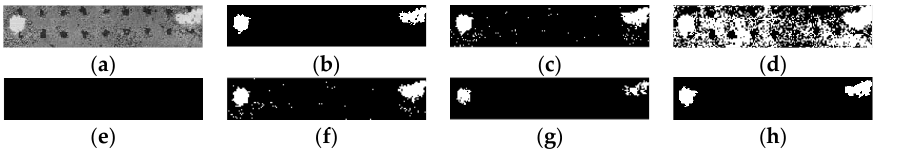
Figure 9. Image13 and its segmentation results: ( a ) #image13, ( b ) ground-truth, ( c ) Otus, ( d ) MRCUT, ( e ) EITMIS, ( f ) NSWCC, ( g ) IT2FSWCC, ( h ) FSEFTISRI.